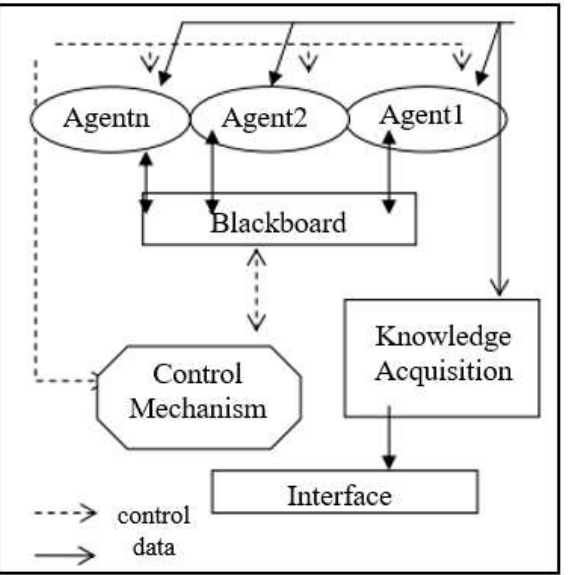
Figure 2. The blackboard model of Multi-Agent Systems. Data are able to flow between the Black- board, Agent, and via request through the interface for knowledge acquisition. Control of the system occurs through the control mechanism, which can influence the blackboard and agents. Credit to Okba Kazar, “Multi-agents system for medical diagnosis” Reprinted/adapted with permission from Ref. [21]. 2018, Okba Kazar.